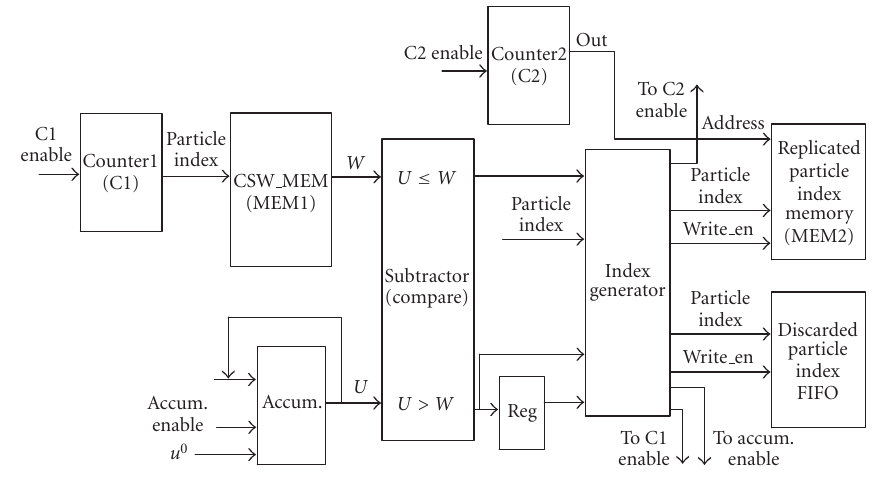
Figure 6: Architecture of resampling unit implementing SR.